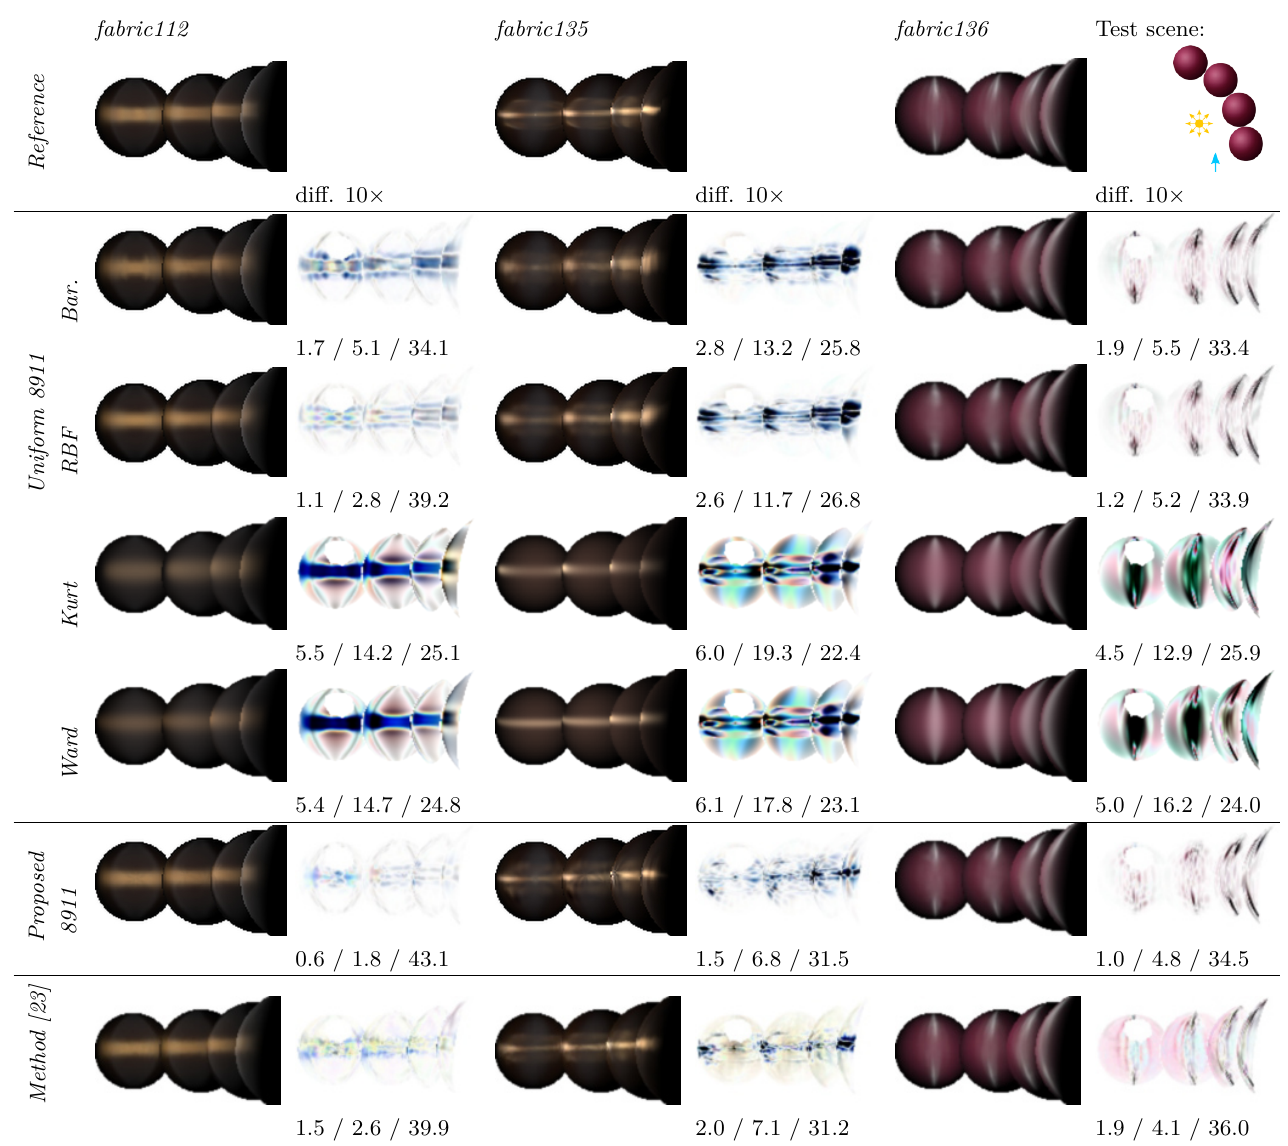
Fig. 12 All reachable directions in the virtual scene (see Fig. 11) measured and compared with barycentric and RBF interpolations of uniformly measured data, fits of two analytical models ([20, 22]), and our proposed adaptive measurement. 8911 samples were used. Difference values are given as CIE ∆ E / RMSE / PSNR (dB). The last row shows results of dense BRDF measurement